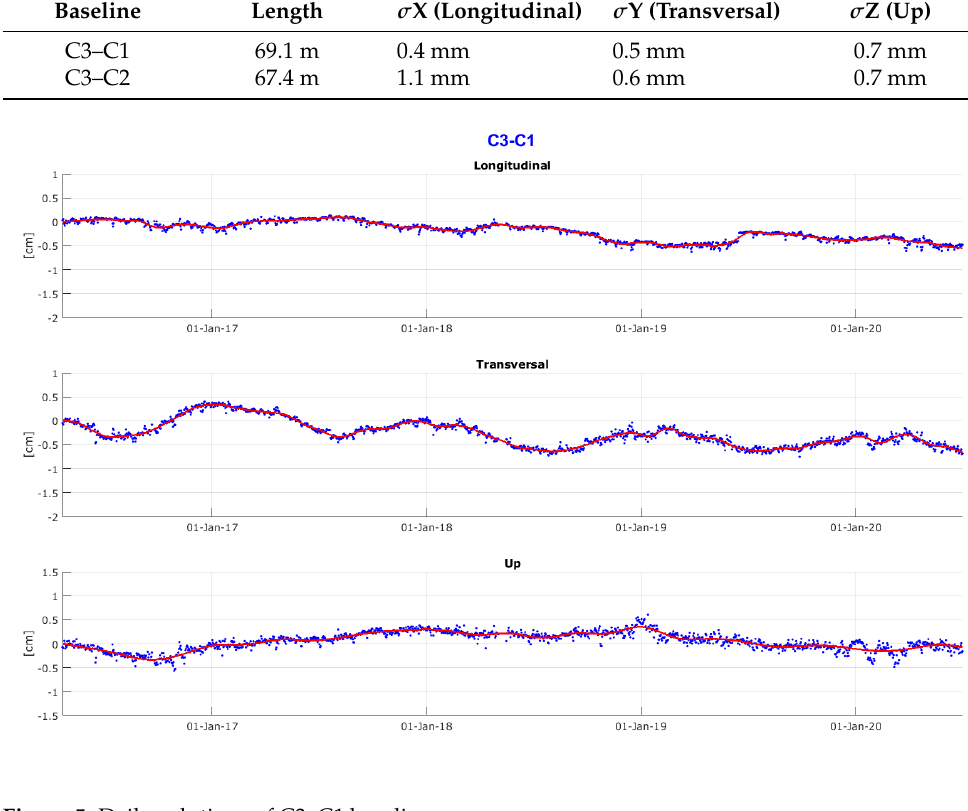
Figure 5. Daily solutions of C3–C1